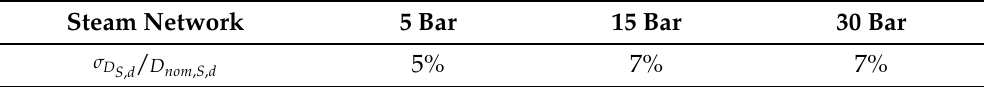
Table 3. The relative uncertainty of the steam demand of the steam networks of INEOS in